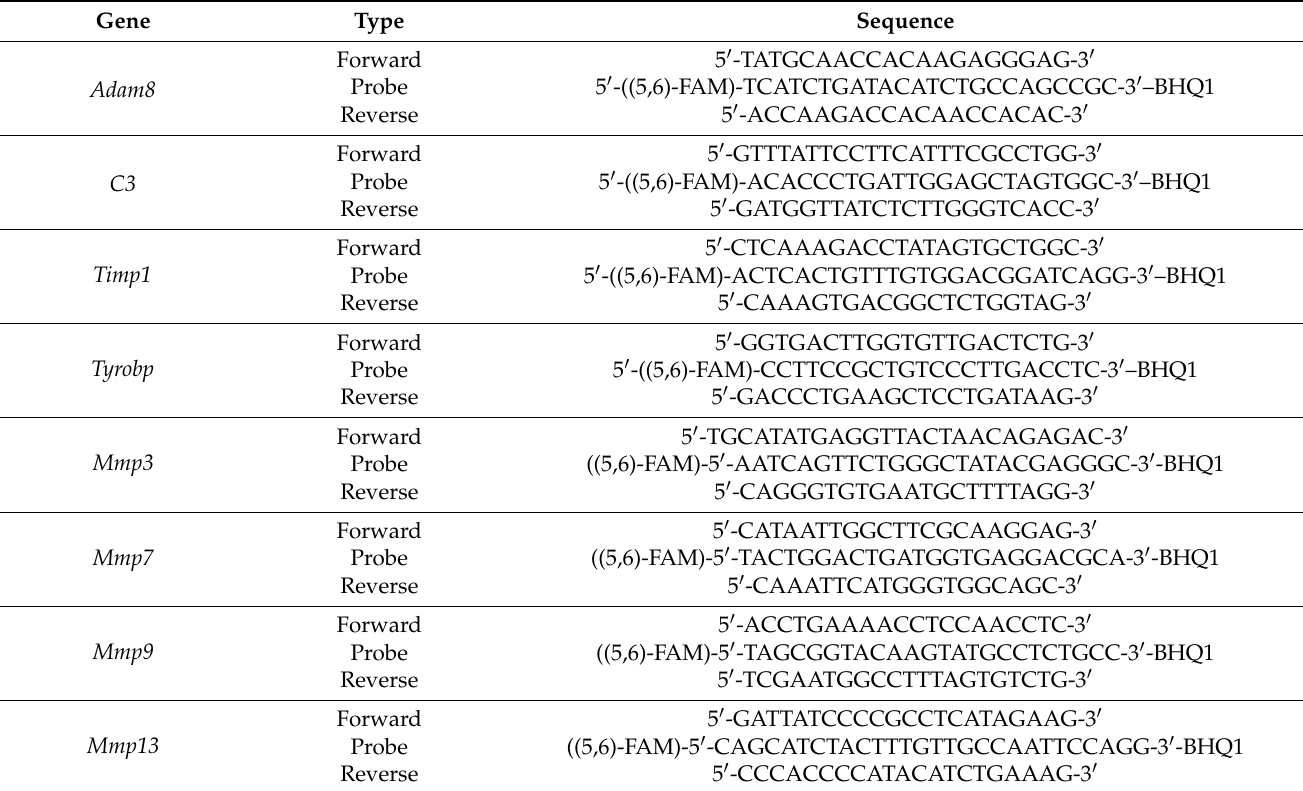
Table 2. Primers used in the